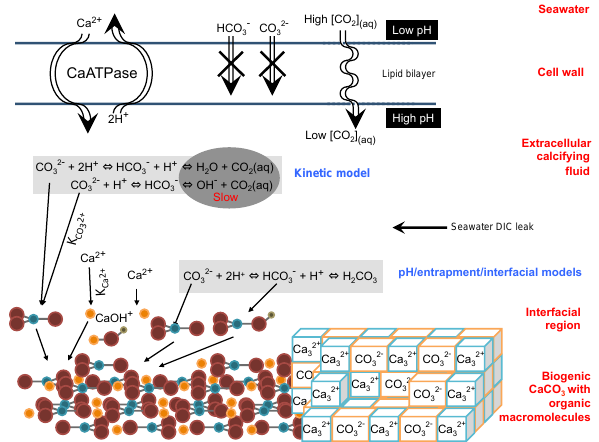
Figure 11. Schematic of the scleractinian coral-calcifying region (modified from McConnaughey, 1989a; Adkins et al., 2003) illus- trating processes that are hypothesized to result in stable isotope signatures observed in corals. Calcium pumping across the cell wall establishes a pH gradient between seawater and the extracellular calcifying fluid. Within the calcifying fluid, carbon can be sourced from CO 2 that is diffusively transported across the cell wall and/or through seawater leakage. The hydration and/or hydroxylation of CO 2 are slow reactions, particularly at low temperature and at high pH, driving disequilibrium in δ 18 O and in clumped isotope signa- tures. The enzyme carbonic anhydrase will catalyze this reaction if present and sufficiently active. At a given temperature, both HCO − 3 and CO 2 − ions have distinct clumped isotope and δ 18 O signatures, 3 and therefore changes in extracellular calcifying fluid pH may also affect the isotopic composition of minerals, as explored through var- ious models including the pH, surface entrapment, and interfacial models mentioned in the text. Surface kinetic and interfacial pro- cesses and properties (e.g., surface speciation, attachment or detach- ment rates for isotopologues, the occurrence of defects, the nature of protein and saccharide macromolecules) also affect crystal growth and